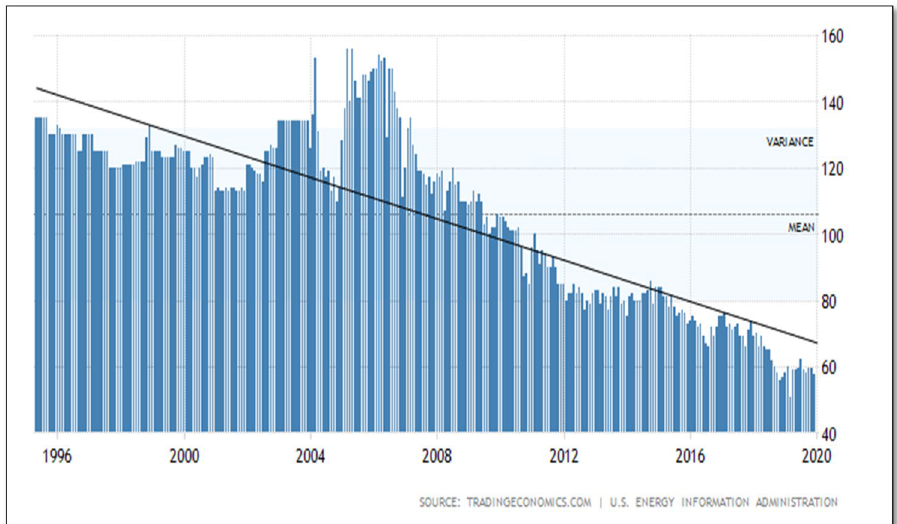
Fig. 1 Crude oil production data from Trinidad and Tobago by year from 1994 to 2019 (https ://tradi ngeco nomic s.com/trini dad-and-tobag o/crude -oil-produ ction )